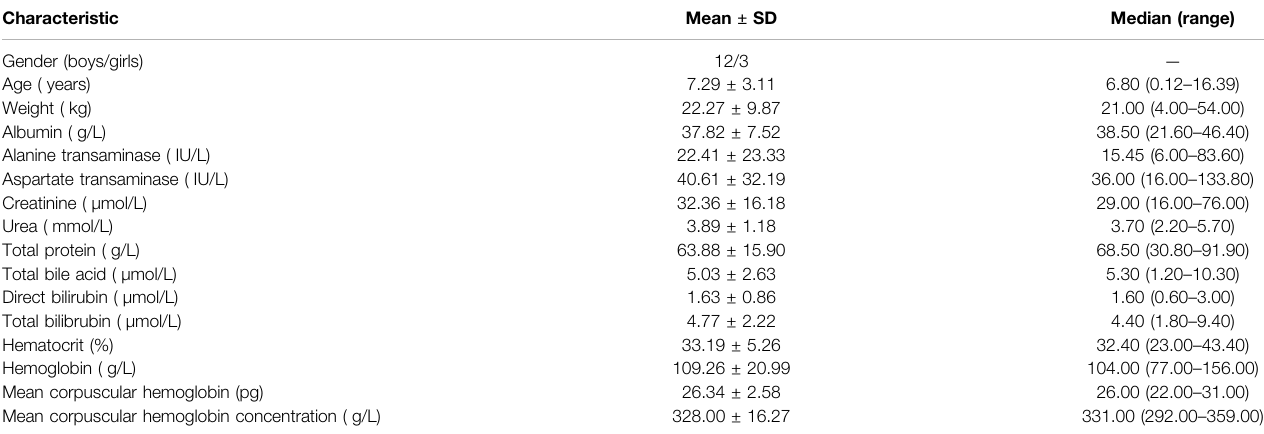
TABLE 1 | Demographic data of patients.